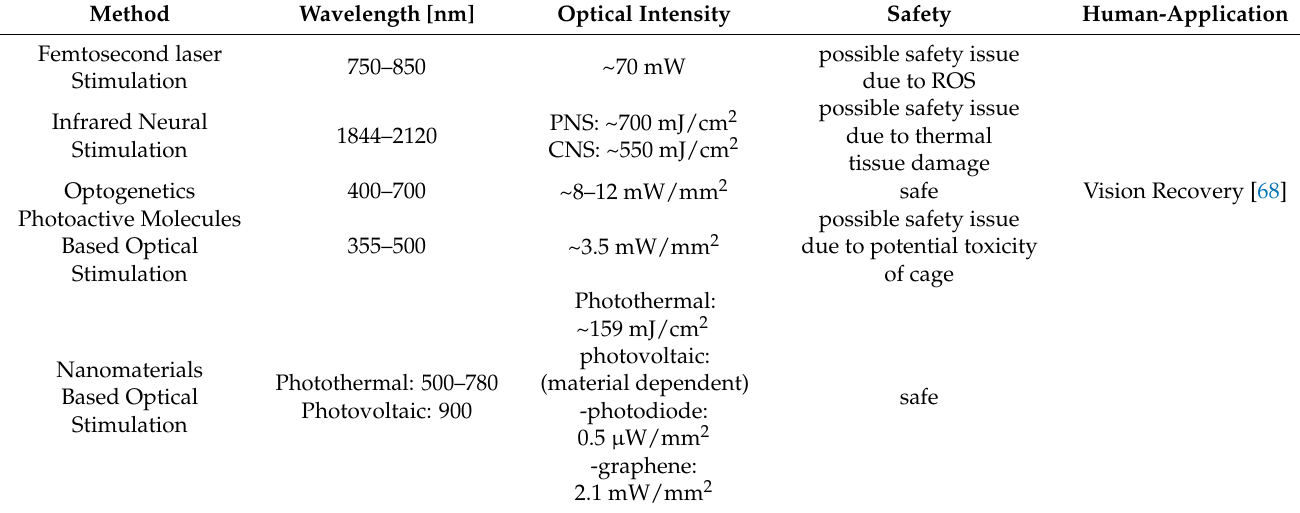
Table 1. Optical neural interface for controlling the neural activities.